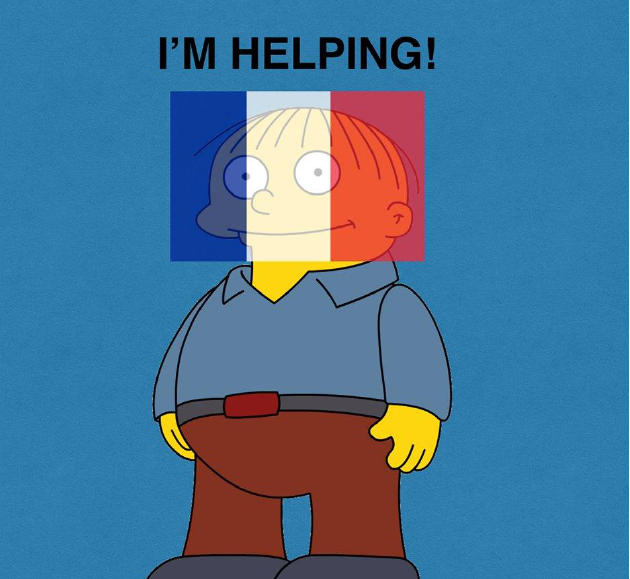
Figure 2. A picture of Ralph Wiggum, a character on the television show The Simpsons , with the French flag superimposed. This image was distributed through sites like Reddit as a criticism of the ‘slacktivism’ of Facebook users who, as a sign of solidarity, added the French flag to their profile pictures using a filter provided by Facebook. Source: